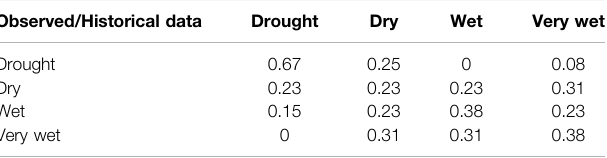
TABLE 1 | Estimated annual transition probabilities between years with different runoff volumes. Years associated with Drought , Dry , Wet , and Very Wet classes span the lowest to highest runoff